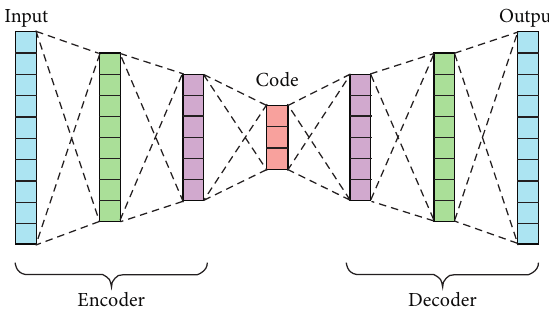
Figure 5: Autoencoder neural network.